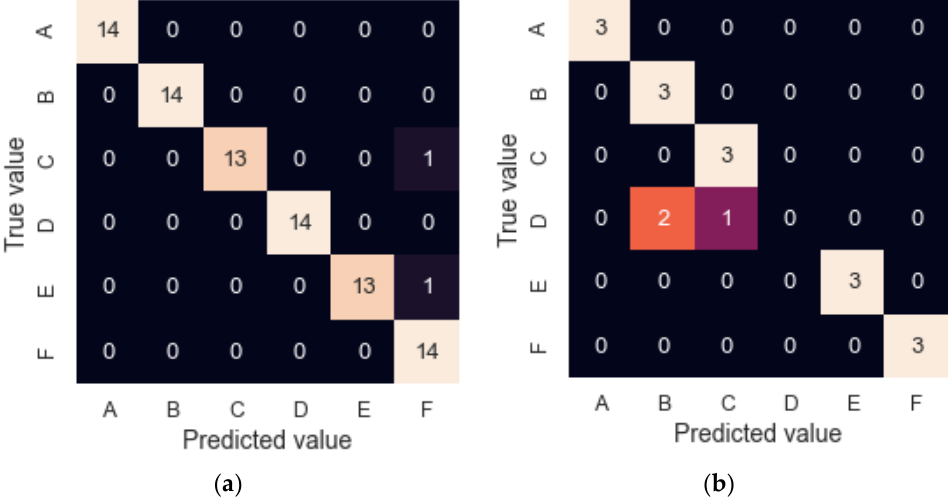
Figure 9. Confusion matrices for granulated cork results. ( a ) LOOCV with 14 cycles; ( b ) CV with the remaining three cycles. Table 3. Real concentration and predicted concentration in